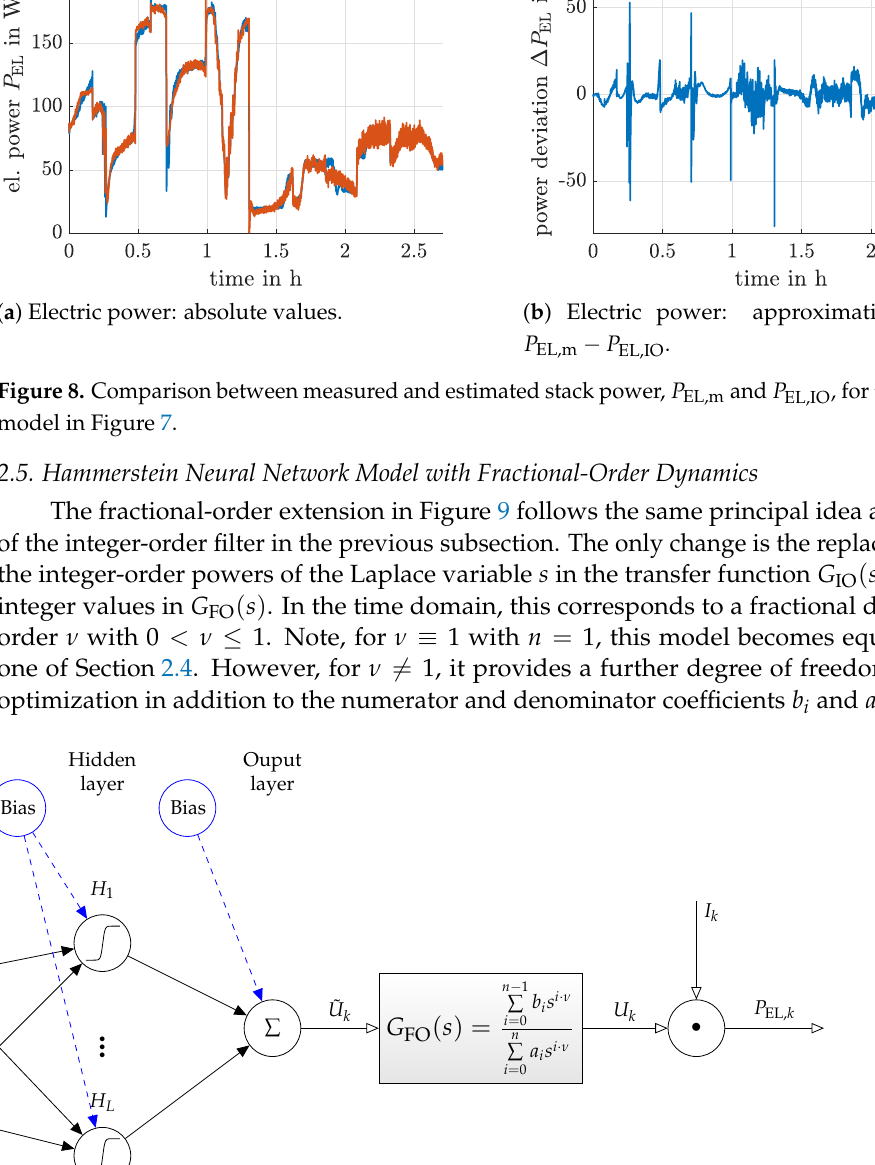
, ˙ m H , ϑ AG,m, k and the output ˜ U k 2 , k 2 , k